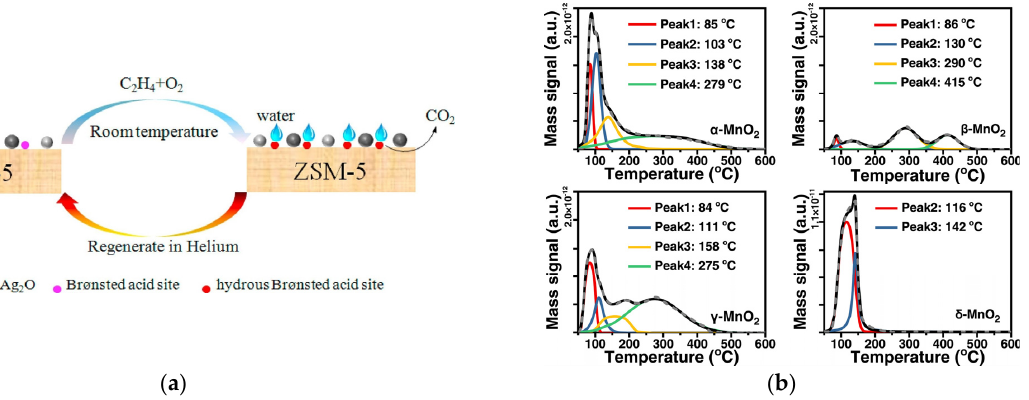
Figure 10. ( a ) The effect of water on the decreased catalytic activity of Ag/ZSM-5 for ethylene oxi- dation at room temperature [51]; ( b ) the H 2 O-TPD profiles of α -MnO 2, β -MnO 2, γ -MnO 2 , and δ -MnO 2